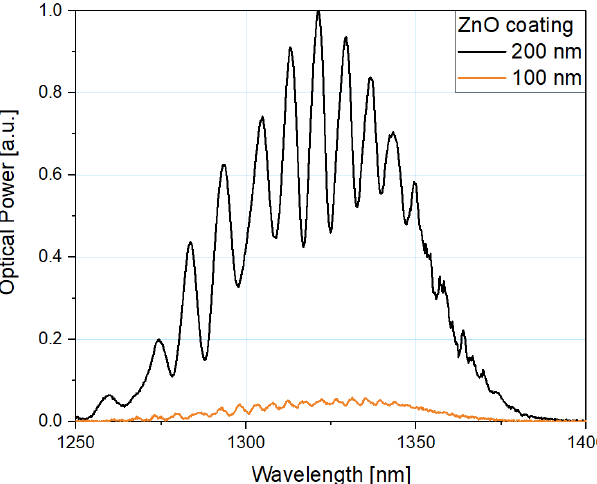
Figure 8. Normalized reflected spectra measured at 100 ◦ C with microsphere-based sensors with a 200 nm (black line) and a 100 nm (orange line) ZnO ALD